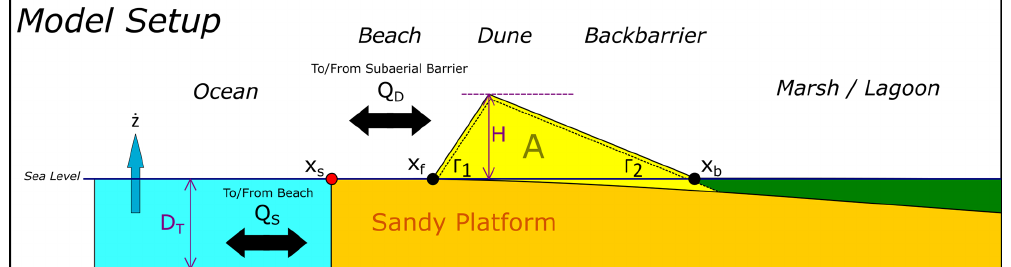
Figure 3. Subaerial Barrier Sediment Partitioning (SBSP) model setup, depicting moving boundaries and processes. Black arrows indicate the bi-directionality of shoreface-to-beach ( Q S ) and beach-to-dune ( Q D ) fluxes, where positive Q S fluxes shift the shoreline (red dot, x s ) seaward and positive Q D fluxes increase the profile area ( A ) of the active subaerial surface (yellow-shaded region above sea level), expanding the foredune toe ( x f ) seaward and the backbarrier–marsh interface ( x b ) landward (black dots). Increases in subaerial cross-sectional volume increase the foredune crest height as function of subaerial geometry, governed by the front slope of the subaerial surface ( (cid:48) 1 ) and the back slope ( (cid:48) 2 ). Coincident with flux contributions and losses, subaerial cross-sectional volume is lost to the subaqueous domain (yellow-shaded region below sea level, not included in A ), becoming part of the barrier substructure due to sea-level rise ( ˙ z ). The thickness of the barrier substructure is denoted by D T , the depth of the active shoreface over decadal timescales. The backbarrier slope of the sandy platform is shown for illustrative purposes and is not currently parameterized in the model.